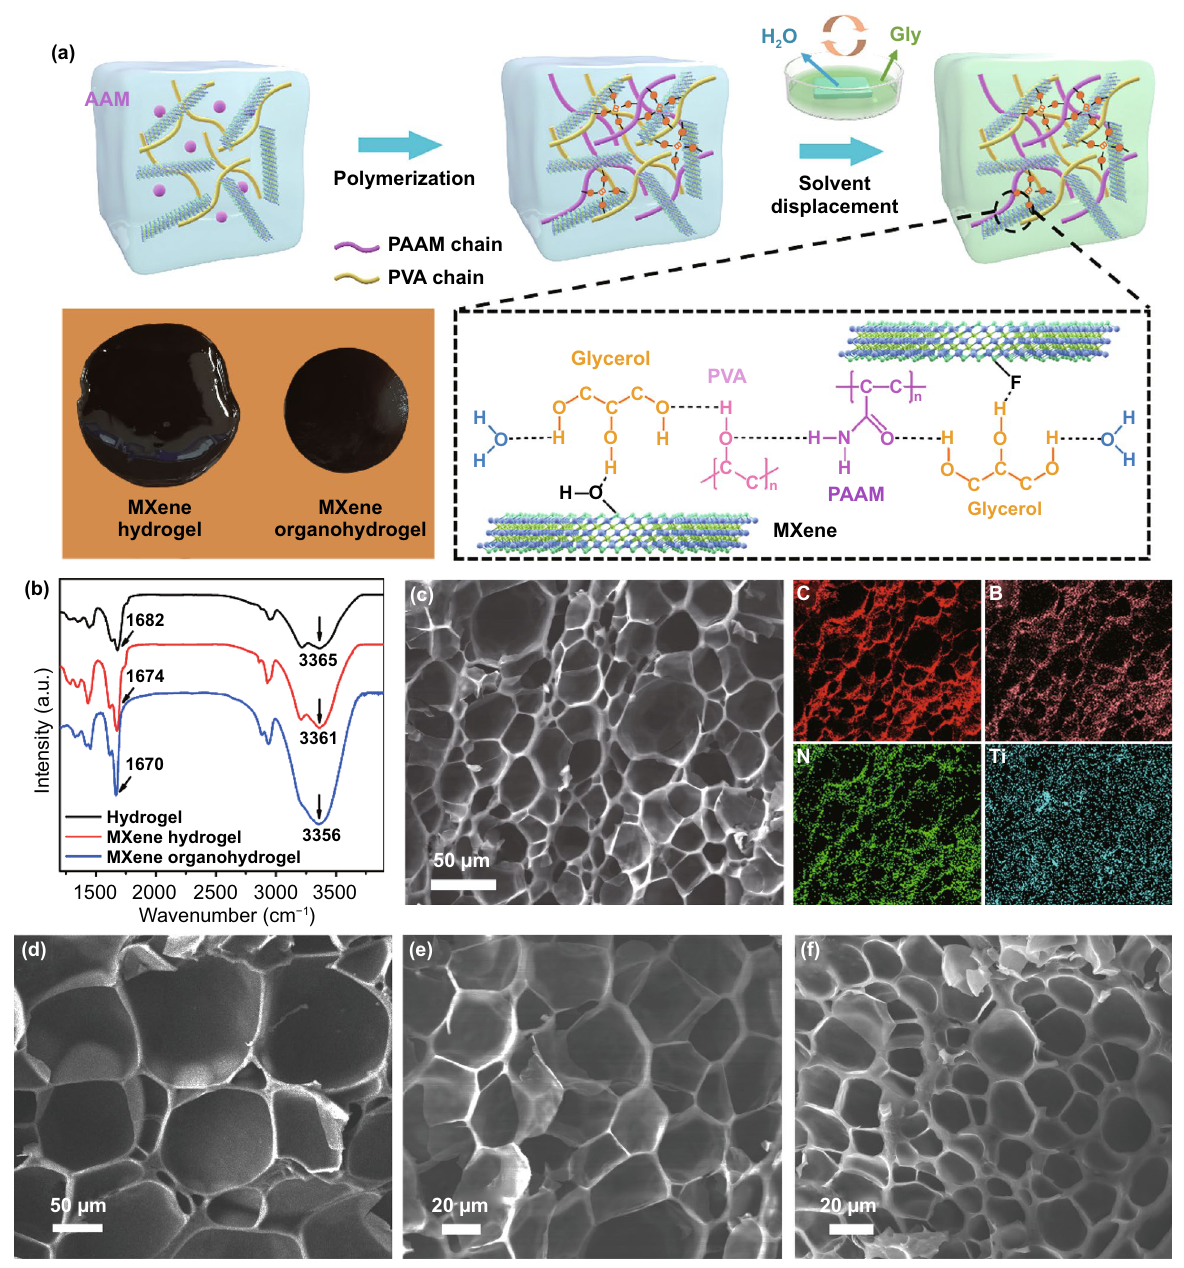
Fig. 1 a Scheme of the synthesis of MXene hydrogel and organohydrogel, and photos of MXene hydrogel and organohydrogel. b FT-IR spectra of pure hydrogel, MXene hydrogel and MXene organohydrogel. c Elemental mapping images of MXene organohydrogel (MXene content of 0.4 wt%, Gly displacement time of 30 min). Cross-sectional SEM images of freeze-dried MXene organohydrogel (MXene content of 0.4 wt%) with different Gly displacement time (Gly: water = 1:1): d 0 min, e 30 min, f 60